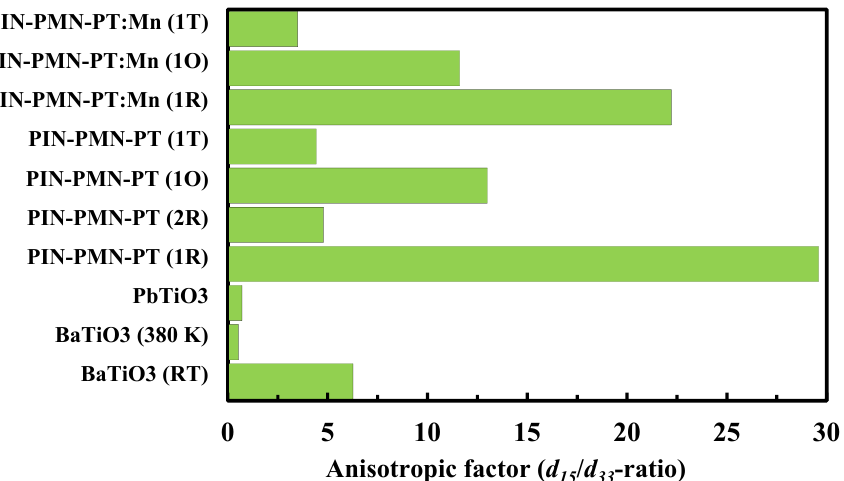
Figure 6. Anisotropic factors of various ferroelectric single crystals. Data from references [35– 37,131,154,157,159,166,167].